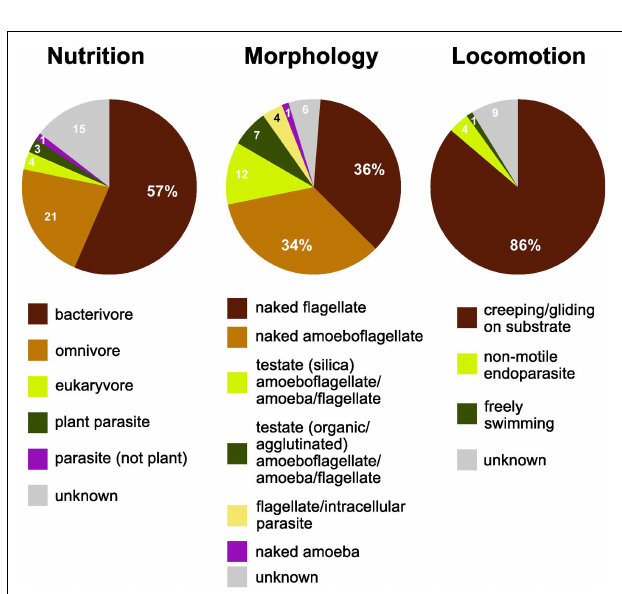
FIGURE 2 | Functional diversity of cercozoan taxa. The relative proportions of functional groups classified according to nutrition, morphology, and locomotion